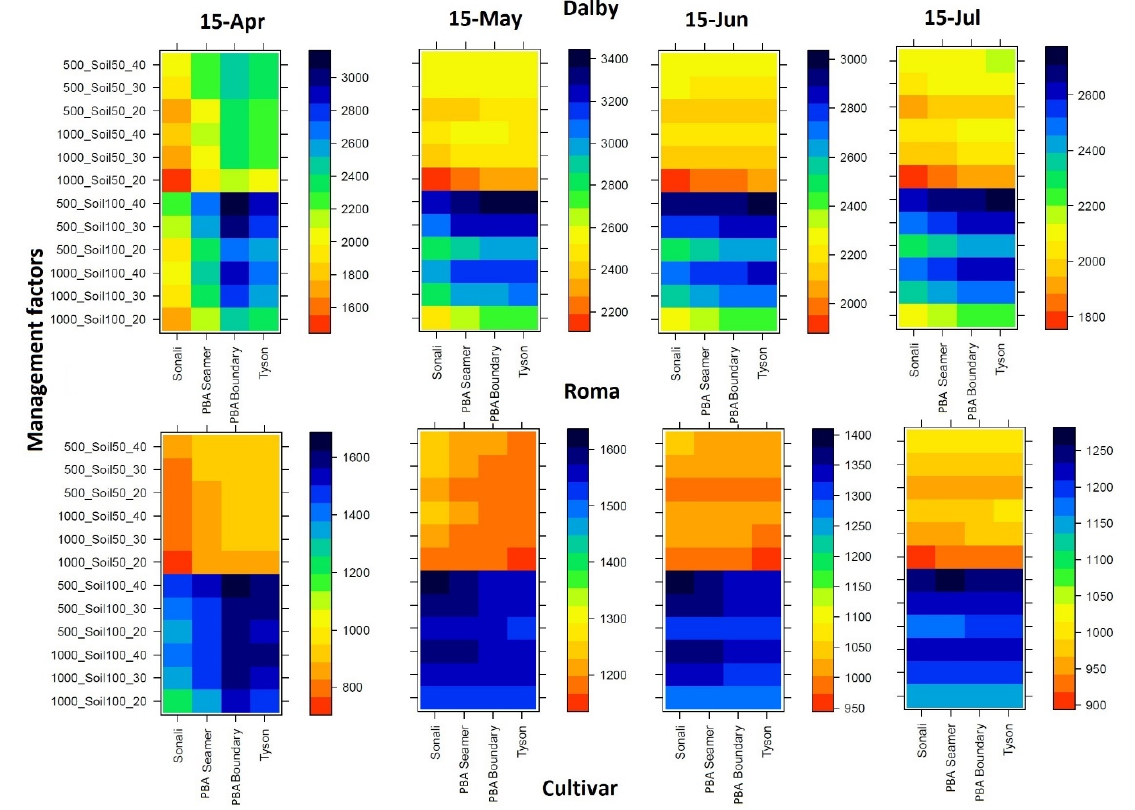
Figure 7. In silico visualisation of Genotype x Environment x Management interactions to guide identification of higher yielding cultivar (G) and agronomy for different environments (E) for Dalby and Roma. The management (M) factors included two row spacings (500, 1000 mm), half and full starting profile (representing double crop and fallow situations, respectively) and 20, 30, and 40 plants/m 2 adopted on four sowing dates. The bar on the right side of each panel is yield (kg/ha).